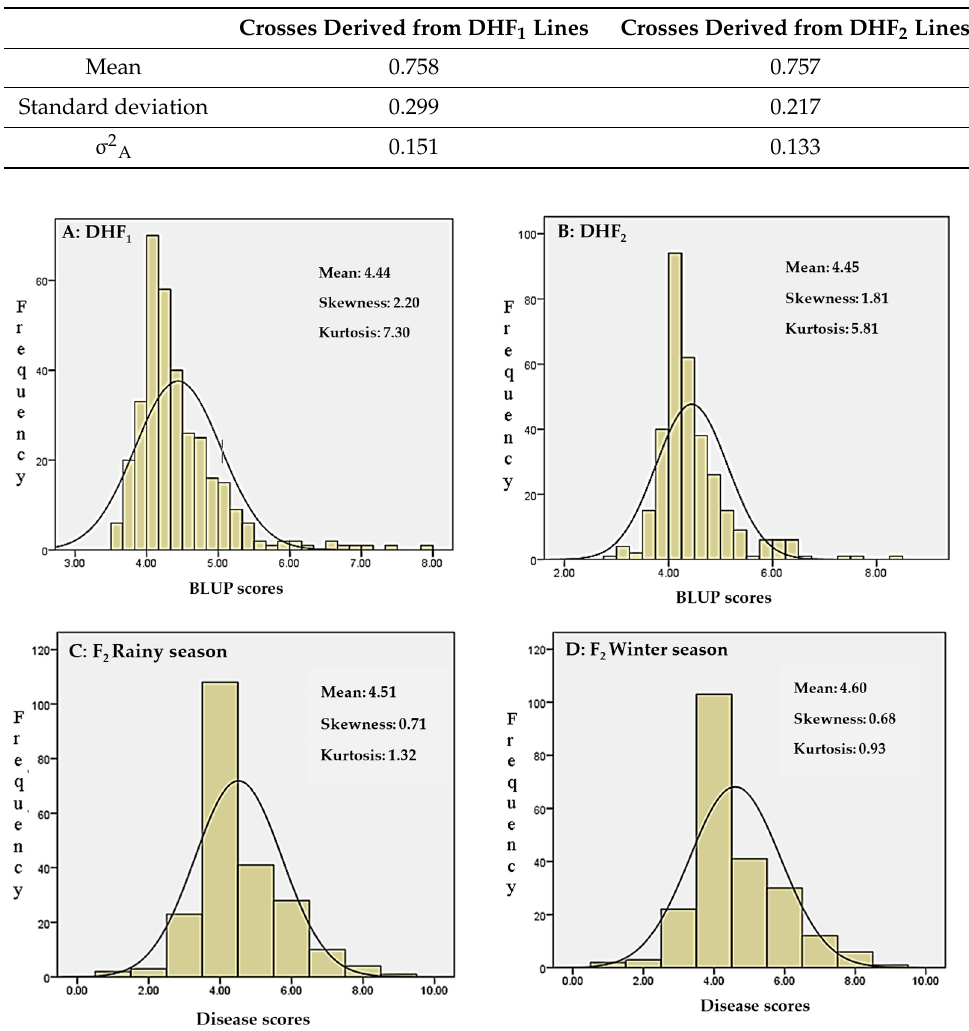
Figure 3. Frequency distribution for FSR disease response in DHF 1 , DHF 2 , and F 2 plants of the cross VL1043 × CM212 ( A ), DHF 1 lines ( B ), DHF 2 lines ( C ), F 2 plants during rainy season ( D ), F 2 plants during winter season.